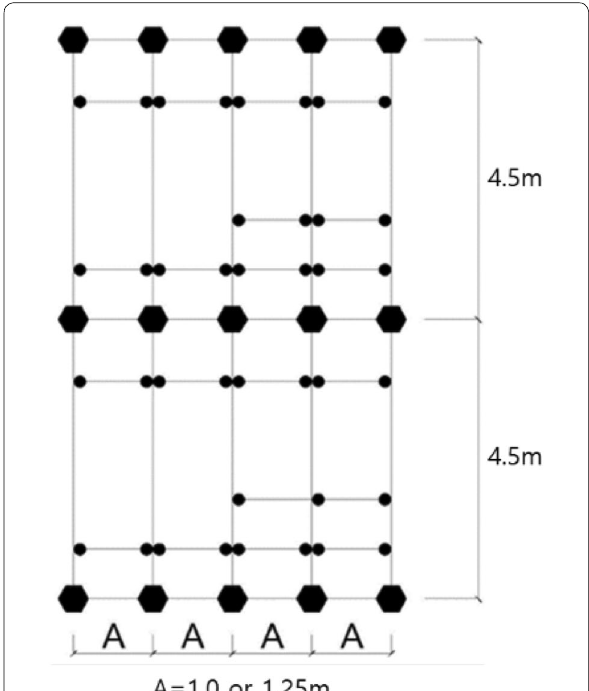
Fig. 2 Structural analysis